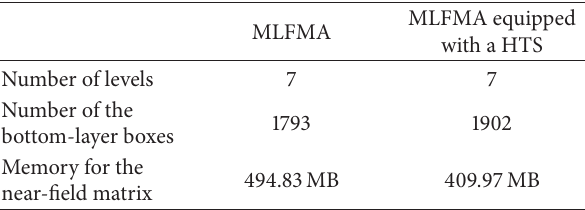
MLFMA equipped MLFMA with a HTS 1793 1902 494.83 MB 409.97